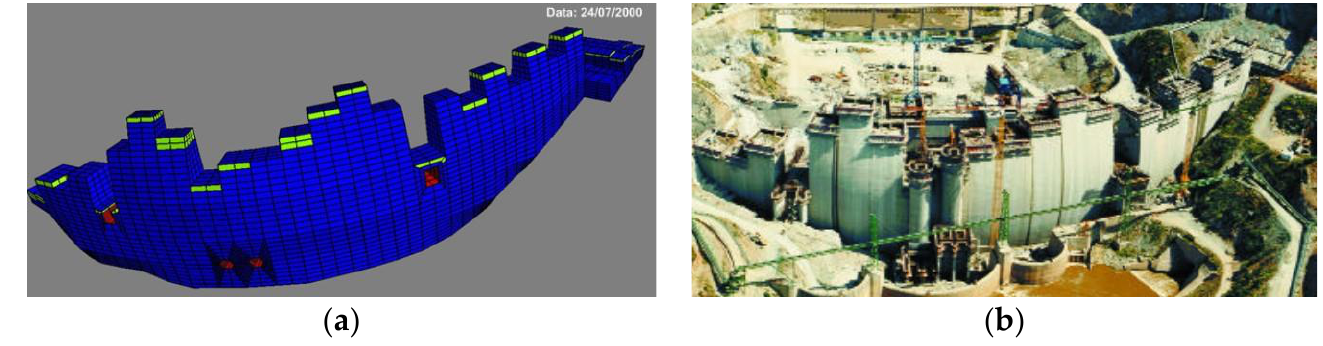
Figure 1. Construction phase with ( a ) FEM simulation and ( b ) aerial view of the dam.